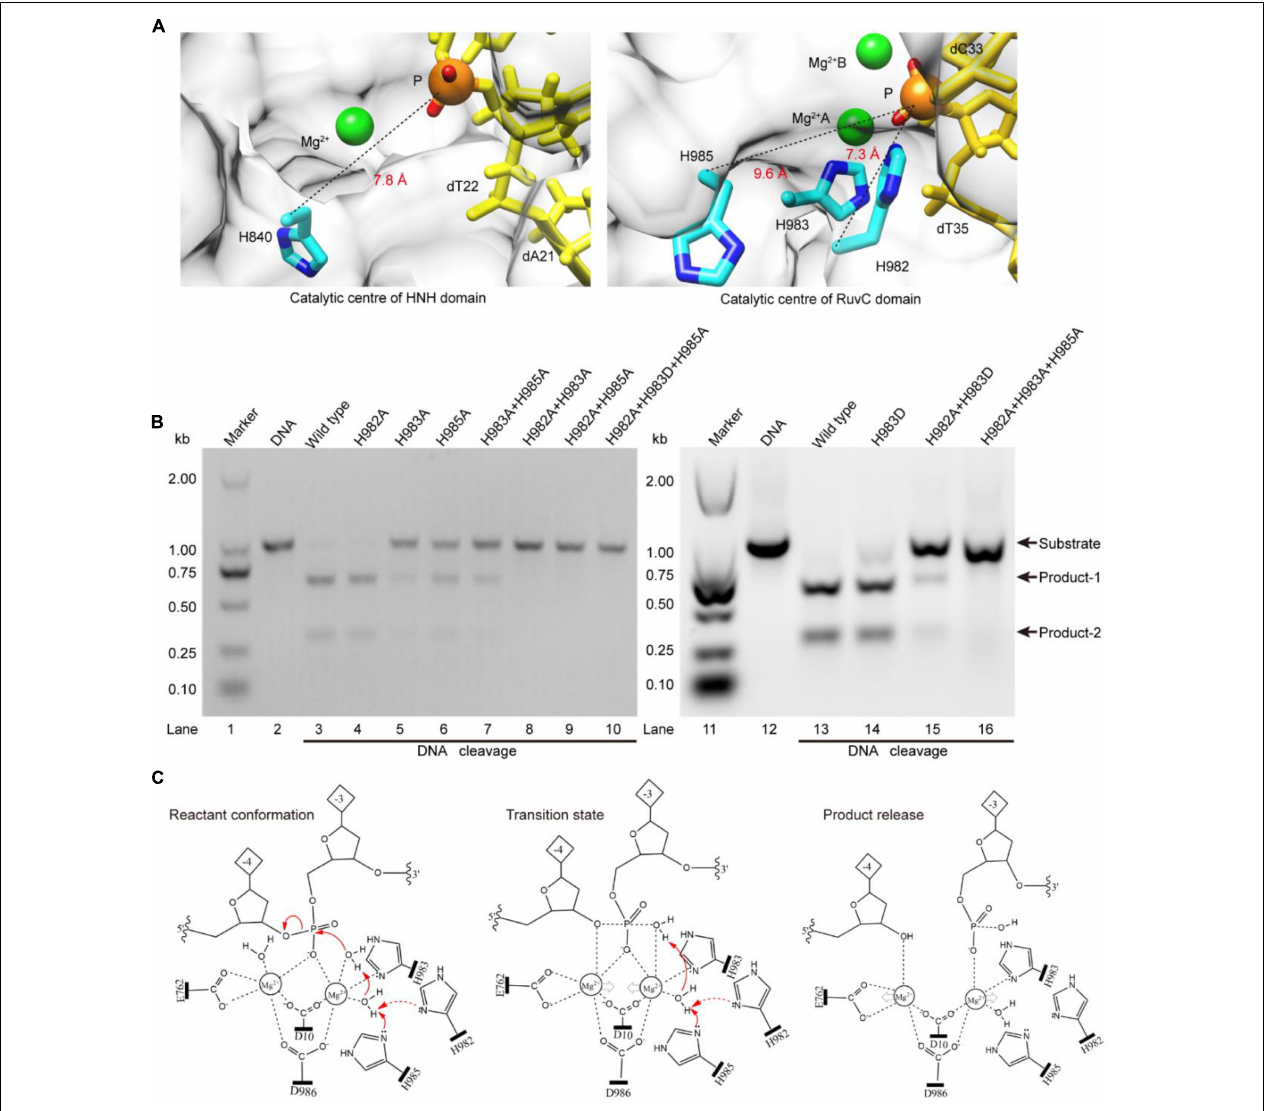
FIGURE 3 | The Lewis bases in the SpCas9 catalytic centers. (A) The Lewis bases in the HNH and the RuvC. H840 is the Lewis base in the one-metal domain; H982 and H985 are the potential Lewis bases in the two-metal domain. (B) In vitro cleavage activities of the SpCas9 mutants. The target DNA molecules are cleaved into two products (product-1 and -2). (C) The two-metal-ion model of the RuvC domain. Reactant conformation: the cooperative motion of two metal ions. Transition state: the high-energy intermediate. Product release: the cleavage and breakage of the target DNA